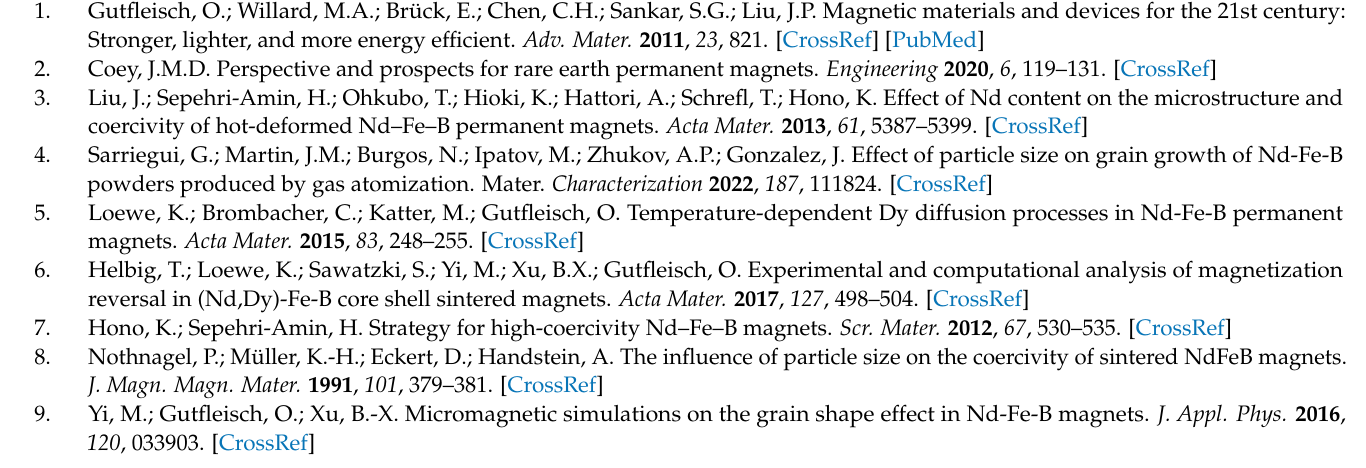
Figure S5: Calculated isothermal section of the Dy-Fe-B ternary system at 1073 K. I-VI denote Dy2Fe14B, Dy1.1Fe4B4, DyFe2B2, DyFeB4, Dy3FeB7, and Dy2FeB3, respectively. The thermodynamic data of DyFe2B2, DyFeB4, Dy3FeB7, and Dy2FeB3 stoichiometric phases are not shown in this work for the melting points are absent. Figure S6: Calculated isothermal section of the Dy-Fe-B ternary system at 1500